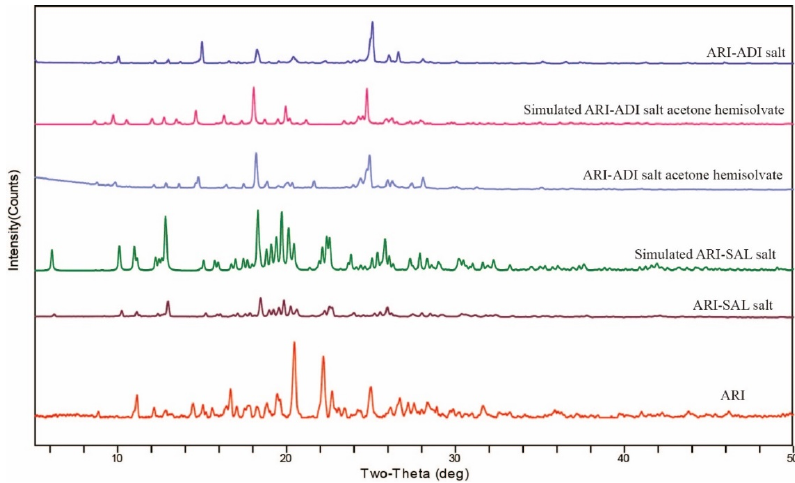
Figure 4. PXRD patterns of ARI and its crystal